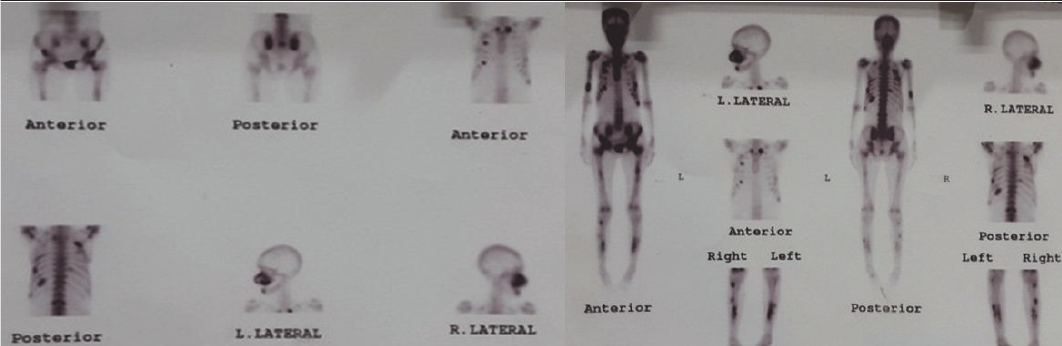
Figure 3: Preoperative whole body scan.